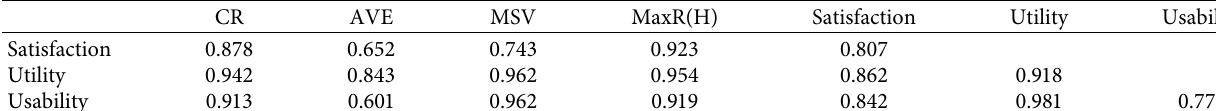
Table 6: Reliability and validity indices of model 3.